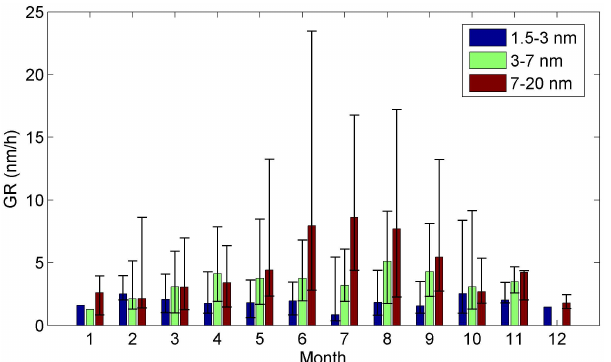
Fig. 2. Monthly median growth rates of particles in the size ranges 1.5–3nm, 3–7nm and 7–20nm during the years 2003–2009. The whiskers represent the 10th and 90th